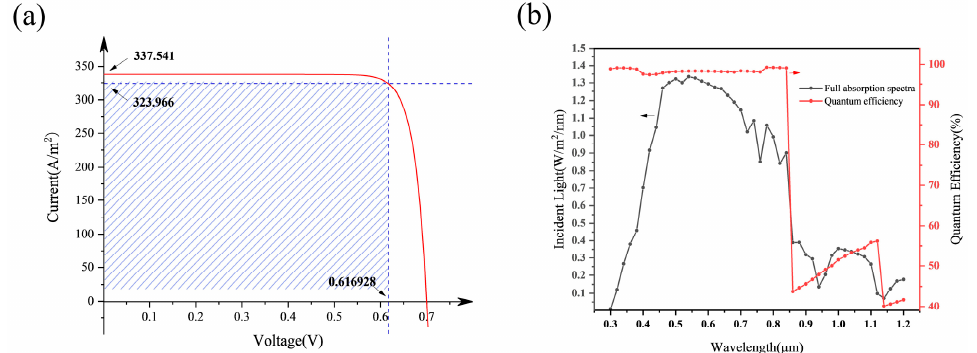
Figure 10. ( a ) The current–voltage curves of the optimal structure. ( b ) The dependance of total absorption spectrum and quantum efficiency of the absorption layer on the wavelength.